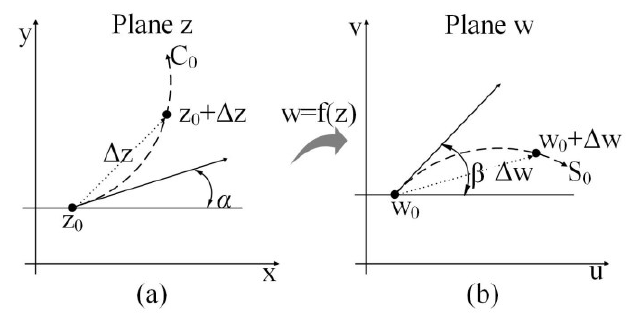
Fig. 5: Slope angle (a) α in Plane z and (b) β in Plane w.